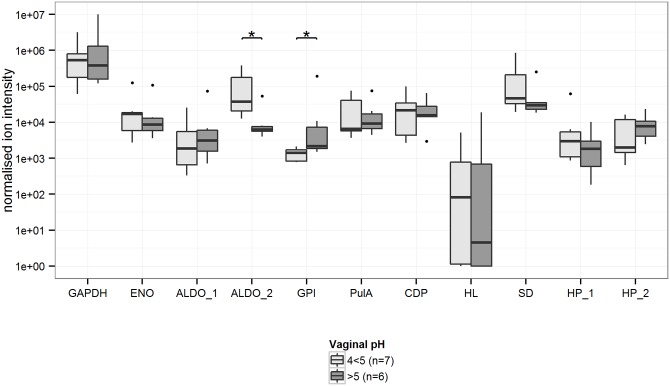
Relative abundances of L. crispatus proteins in cervicovaginal lavages of women with positive L. crispatus 16S rDNA microarray results (n = 13) among two vaginal pH categories.Homologous proteins from different strains are numbered (Table 1). Box plots represent median (black line), first and third quartiles (box) and range within 1.5 times the interquartile range from the box (whiskers). Outliers are plotted as points. *p-value<0.05. Abbreviations: GAPDH: glyceraldehyde-3-phosphate dehydrogenase; ENO: enolase; ALDO: fructose-bisphosphate aldolase; GPI: glucose-6-phosphate isomerase; PulA: pullulanase type I; CDP: cell division protein; HL: hydrolase; SD: YSIRK signal domain/LPXTG anchor domain surface protein; HP: hypothetical protein.